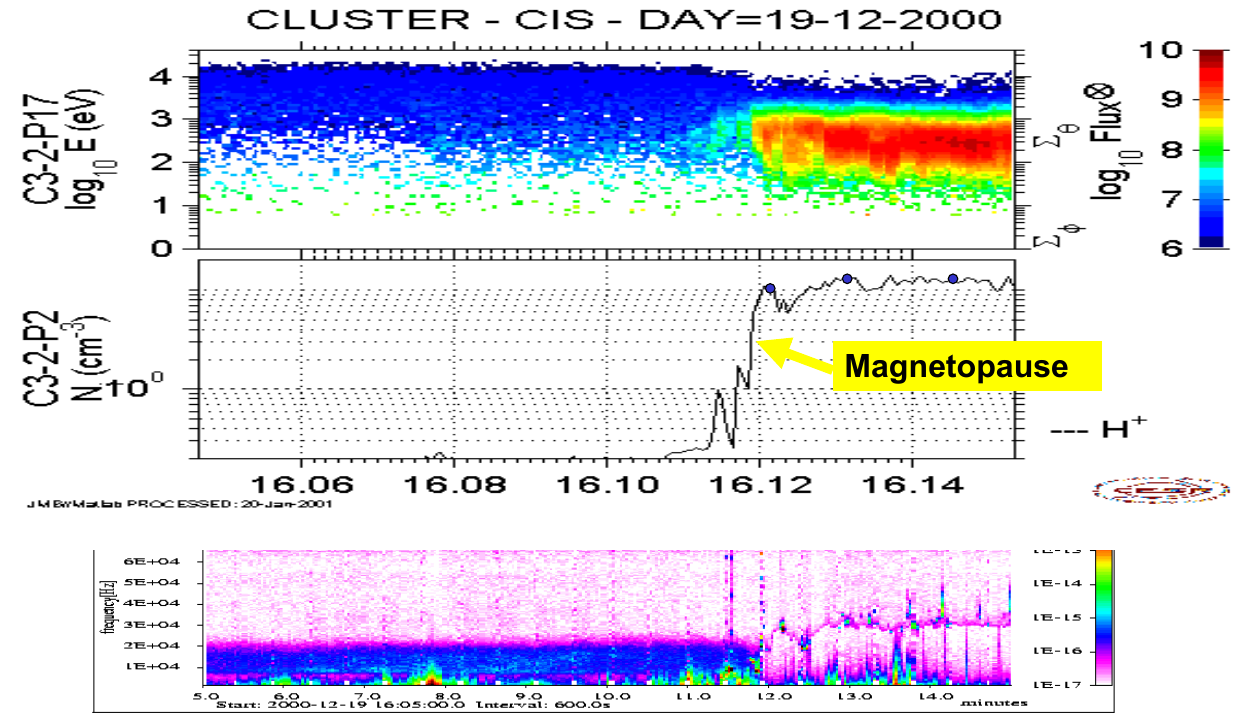
Fig. 18. Comparison of the electron density measured by the Whisper instrument and the ion density measured by HIA, on 19 December 2000 when the spacecraft 3 leaves the magnetosphere and moves into the magnetosheath. At the top are the ion fluxes, at the bottom are the wave measurements of Whisper and in the middle is the density measured by HIA and three-points deduced from the Whisper measurements. The agreement is excellent. Before the magnetopause traversal, the density is too small to be evaluated by